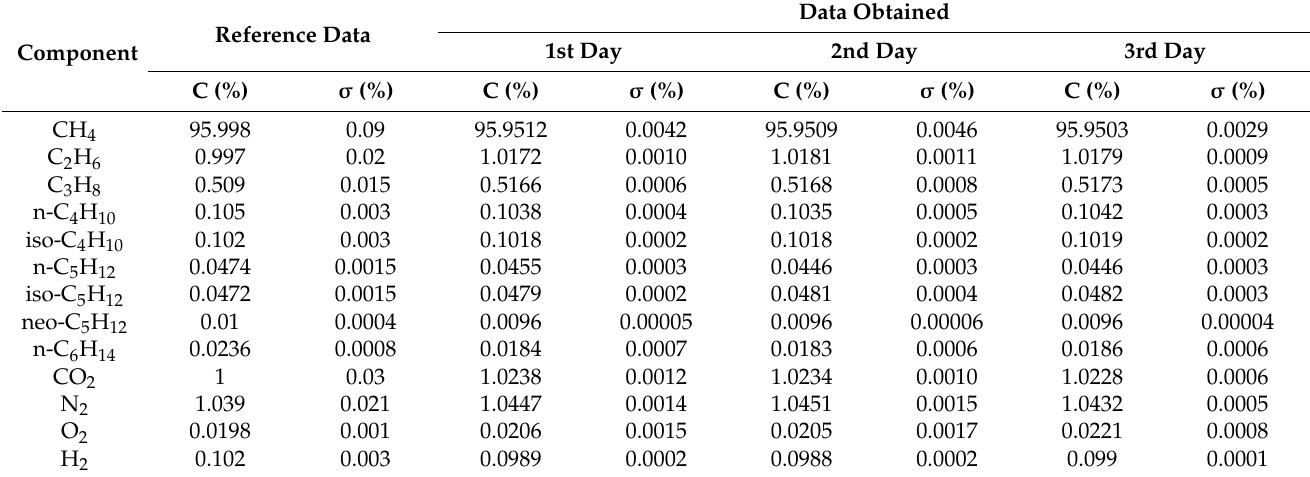
Table 4. Measurement results for sample 2.